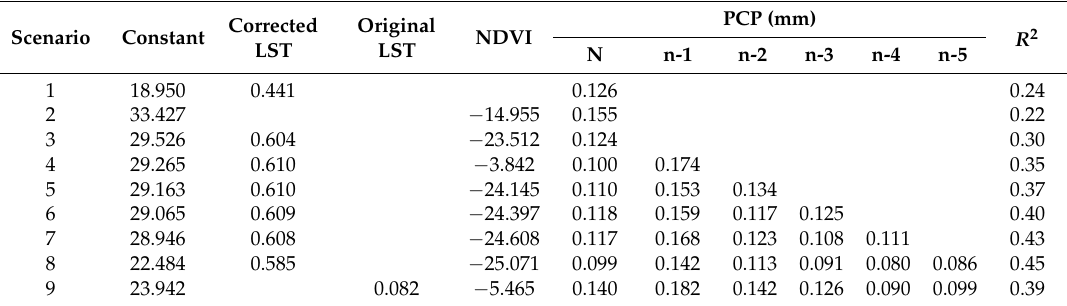
Table 4. Regression coefficients of multiple linear regression for each scenario.